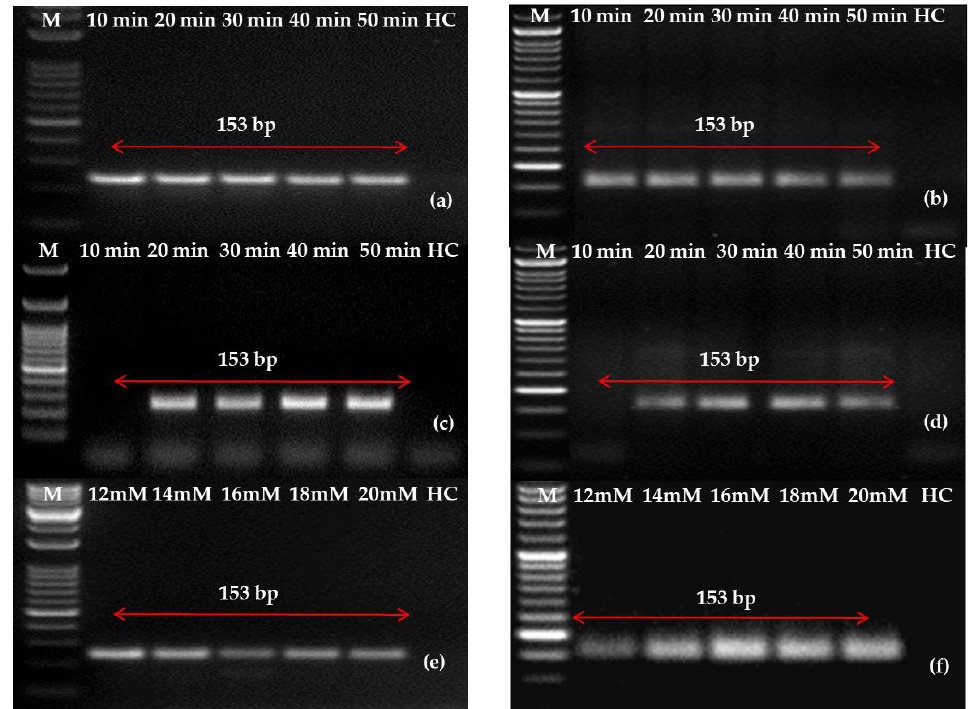
Figure 5. Reverse transcription-recombinase polymerase amplification (RT-RPA) optimization for potato leafroll virus (PLRV) detection using forward and reverse primer LRRPAF3/R3-Set C. The RT-RPA amplified products on ( a ) a PCR machine and ( b ) a water bath using a cDNA template at a temperature of 40 °C and a duration range of 10, 20, 30, 40 and 50 min. Likewise, the RT-RPA amplified amplicons using total RNA (1 µ L) in ( c ) a PCR machine and ( d ) a water bath under the same conditions of temperature and duration. Optimization of magnesium acetate concentrations ranging from 12 mM to 20 mM under a similar setup of ( e ) thermal cycler and ( f ) water bath. Lane M: 50 bp ladder; HC: healthy control.